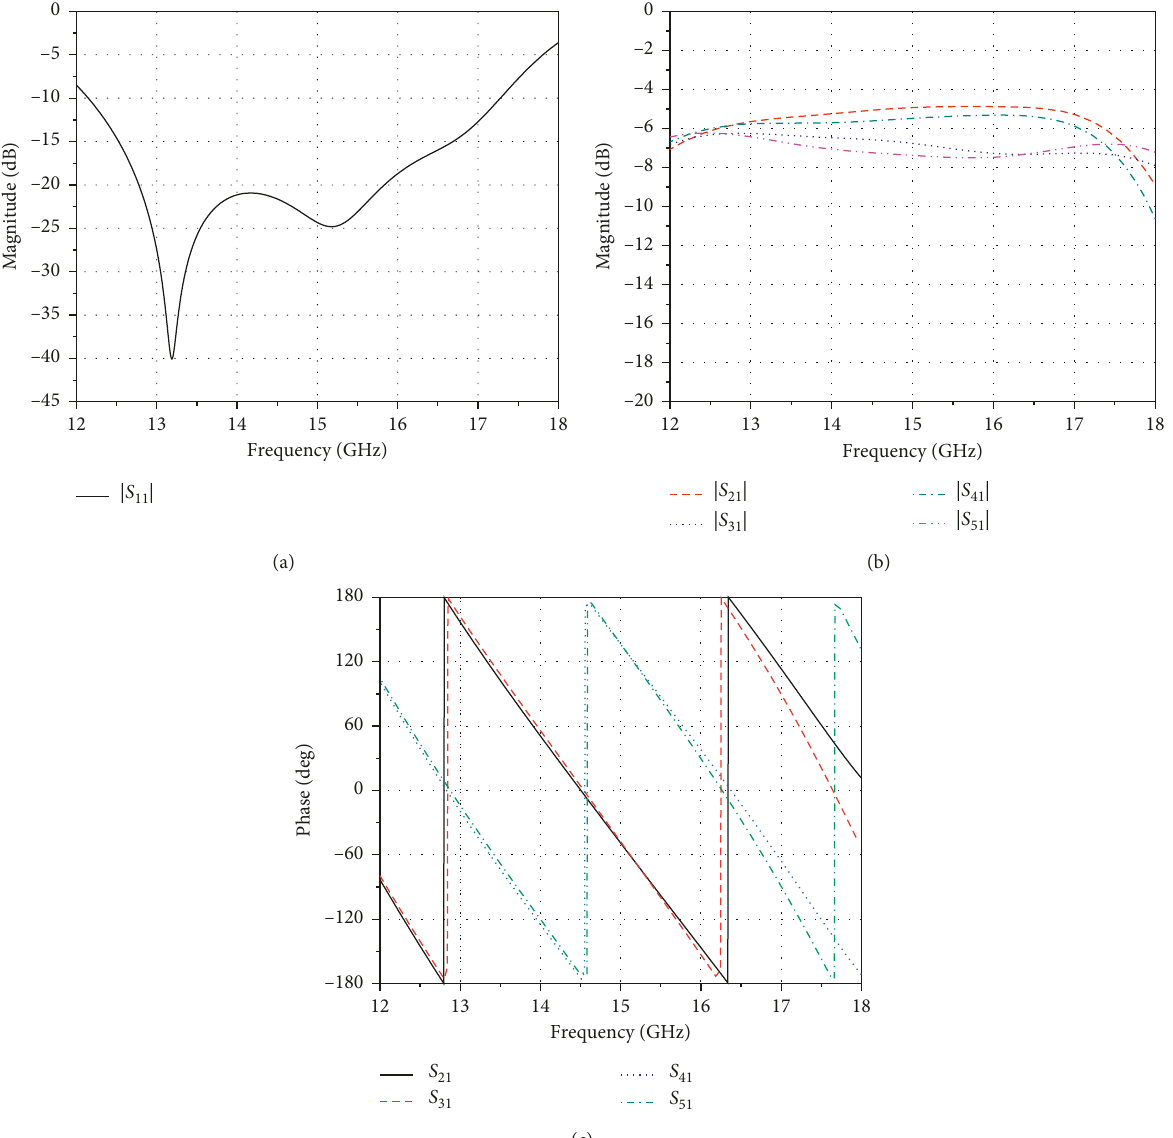
11 . (b) S-parameters. (c) Phase.